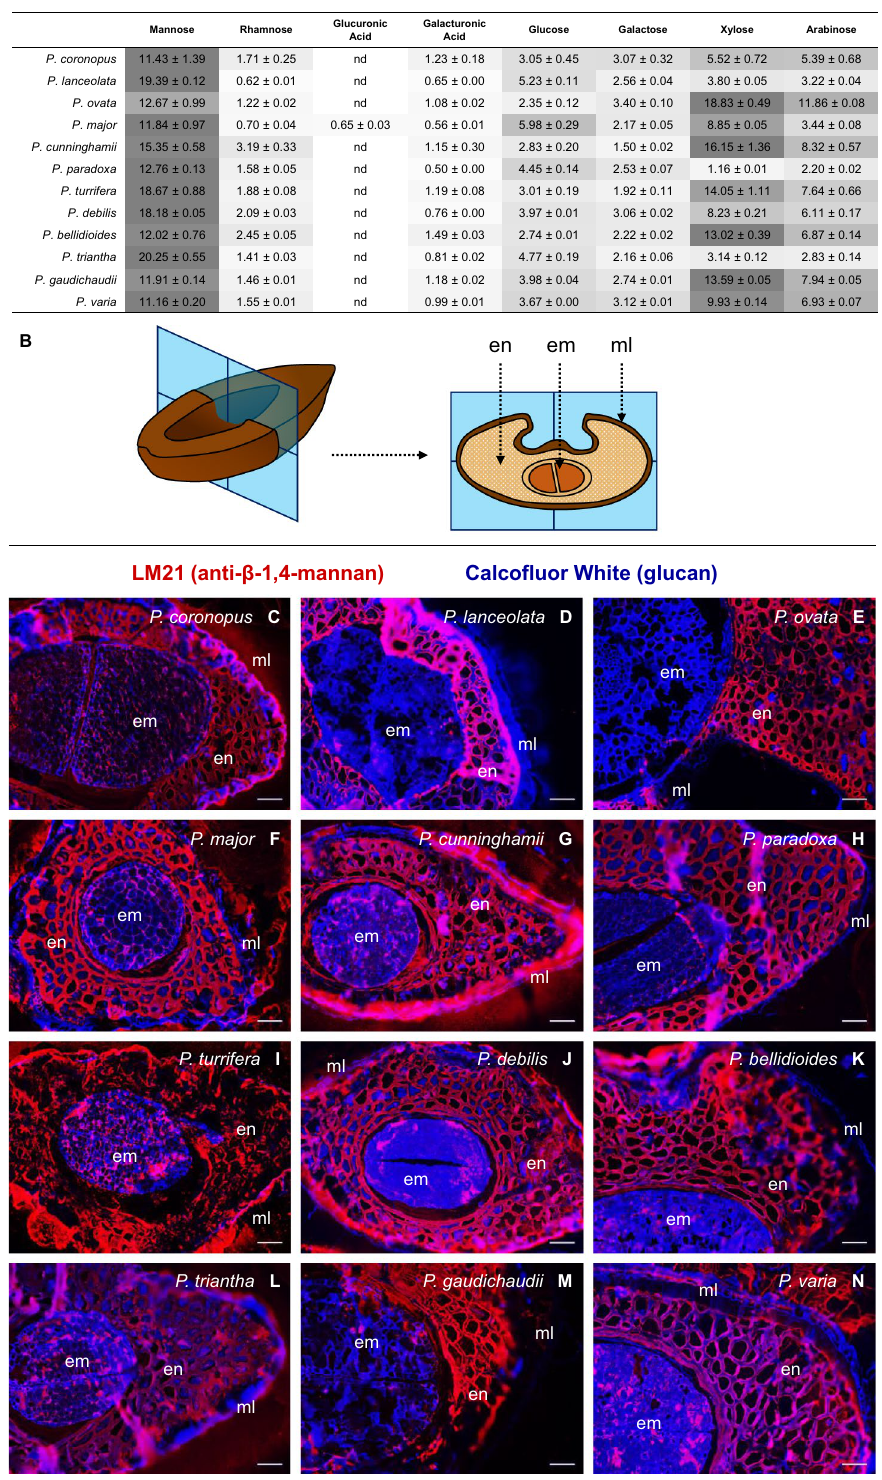
Figure 5. Profiling of the major polysaccharide sugars in Plantago seed. ( A ) Monosaccharide profiles of whole Plantago seeds (means of three replicates, % w/w, with standard deviation). A grey scale (dark grey, highest value; white, lowest value) has been used to highlight the most abundant monosaccharides in a species. ( B ) Schematic diagram of the orientation of thin sections taken from Plantago seeds. ( C–N ) Immunodetection of mannan in Plantago endosperm cell walls by LM21 monoclonal antibody. Scale = 50 μm. Abbreviations: en = endosperm; em = embryo; ml = mucilage